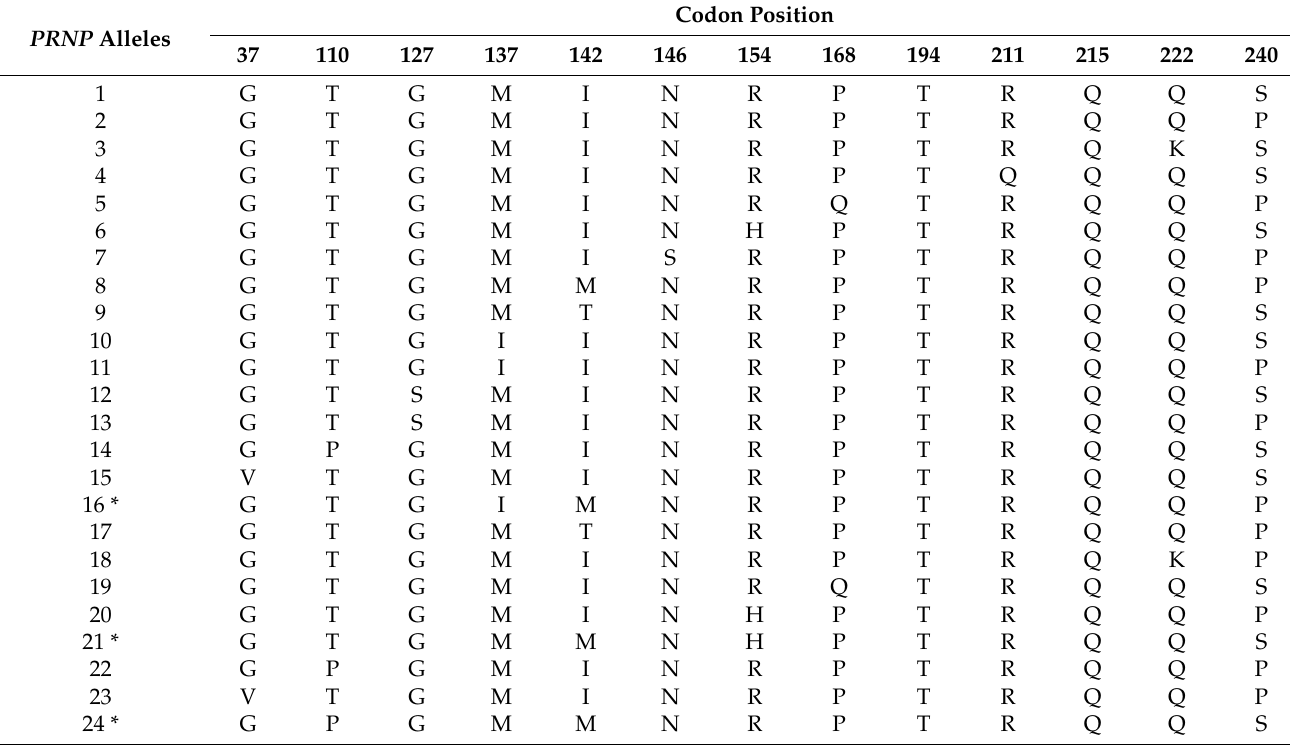
Table 2. PRNP alleles estimated by PHASE 2.1 in caprine